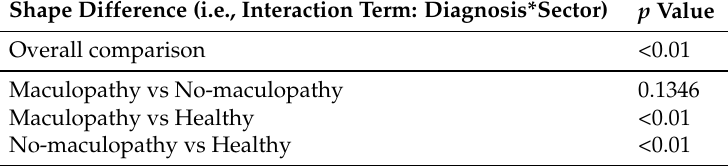
Table 6. Shape difference between diagnosis group using two-level of nested random effects spatial model with spatial correlation